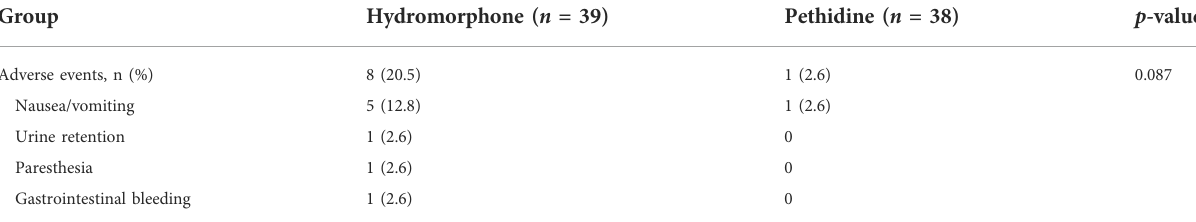
TABLE 4 Adverse events in 77 acute pancreatitis